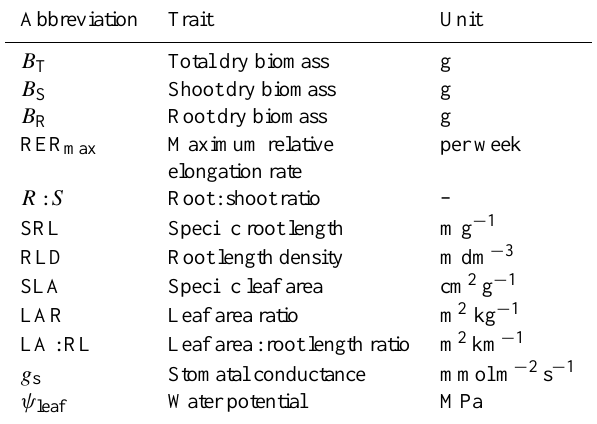
Table 2. List of studied functional traits with abbreviations and